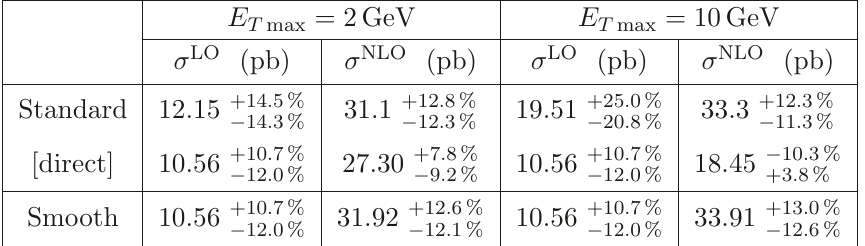
Table 1 . Results for LO and NLO total cross sections with two values of E T max and the photon kinematical cuts described in the text (beginning of section 2.3). The results are obtained by using smooth and standard isolation (the direct component of the standard isolation cross section is also reported). The NLO smooth isolation results use the isolation function χ ( r ; R ) = ( r/R ) 2 n with n = 1. The central values of σ are obtained with the scale choice µ R = µ F = µ frag = M γγ and the scale dependence corresponds to µ R = M γγ / 2, µ F = µ frag = 2 M γγ (upper values) and { } µ R = 2 M γγ , µ F = µ frag = M γγ / 2 (lower values). The last digit of each cross section value has { } an error of one unit from the statistical uncertainty of the numerical